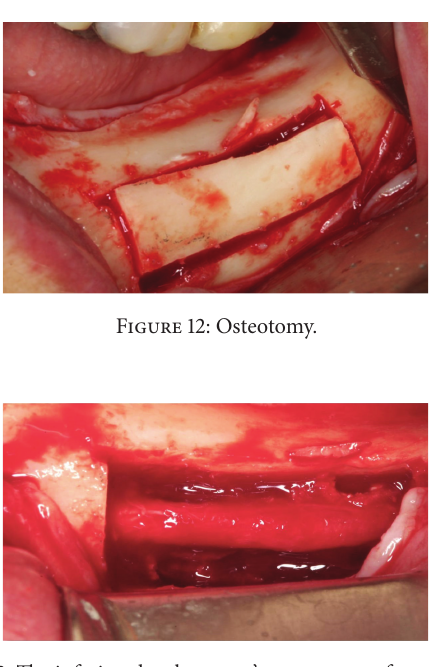
Figure 13: The inferior alveolar nerve’s appearance after removal of bone tissue.